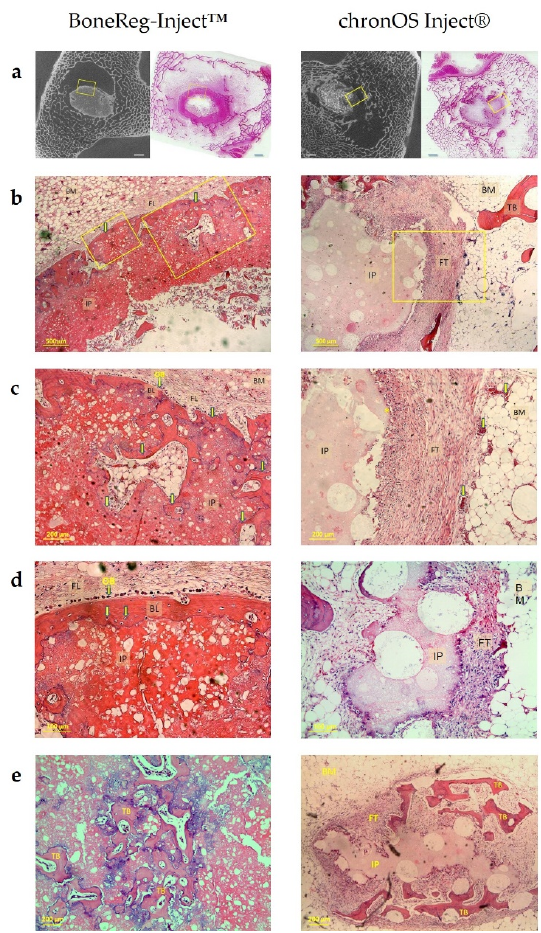
Figure 5. 3 months postoperative. ( a ) An alignment of histological sections with two-dimensional cross-sections of micro CT constructs in a bone marrow/trabecular bone area in the right legs of sheep with BoneReg-Inject™ implant (left column) and chronOS Inject ® implant (right column). The left images in each column show the two-dimensional micro CT cross sections in the plane aligned with the histological section in the right image. The scale bars are 2 mm. BoneReg-Inject™ column: ( b ) Histological section, a close up of the area of the yellow frame shown. ( a ). The rim of neo-osteoid covering the implant is clearly visible (yellow arrows). BM: Bone marrow, FL: Fibrous layer, IP: Implant. ( c ) A close up of the right yellow frame in ( b ). New bone, connected to the bone shell covering the implant, has grown into the implant (yellow arrows). Characteristic blue deposits seen on the interface between new bone and the implant indicate areas of calcification. Osteoblast-like cells (OB) visible on the outer layer of the new bone shell. ( d ) A close up of the left yellow frame in ( b ). The rim of neo-osteoid covering the implant is evident (BL) and individual osteocytes are visible (yellow arrows). Osteoblast-like cells (OB) are visible on the outer layer of the bone shell. ( e ) Trabecular-like neo-osteoid formation inside the BoneReg-Inject™ implant. Blue indicates regions of on-going calcification. chronOS Inject ® column: ( b ) A close up of the yellow frame area shown in ( a ). The fibrous tissue covering the implant is characteristic of the chronOS Inject ® group. The characteristic granules are apparent in the implant. FT: Fibrous tissue, TB: Trabecular bone. ( c ) A close up of the yellow framed area in ( b ) showing the implant surrounded by fibrous tissue and bone marrow. It is characteristic for the chronOS Inject ® group to see this layer of fibrous tissue surrounding the implant (*). Blood vessels with red blood cells are evident both in the bone marrow and fibrous tissue layer (yellow arrows). ( d ) Implant surrounded by fibrous tissue. ( e ) Trabecular-like neo-osteoid (TB) formed inside the layer of fibrous tissue replacing the chronOS Inject ® implant (IP), as it resolves. This formation of new bone was generally rare in the chronOS Inject ® group and was poorly integrated with the existing surrounding trabecular bone.